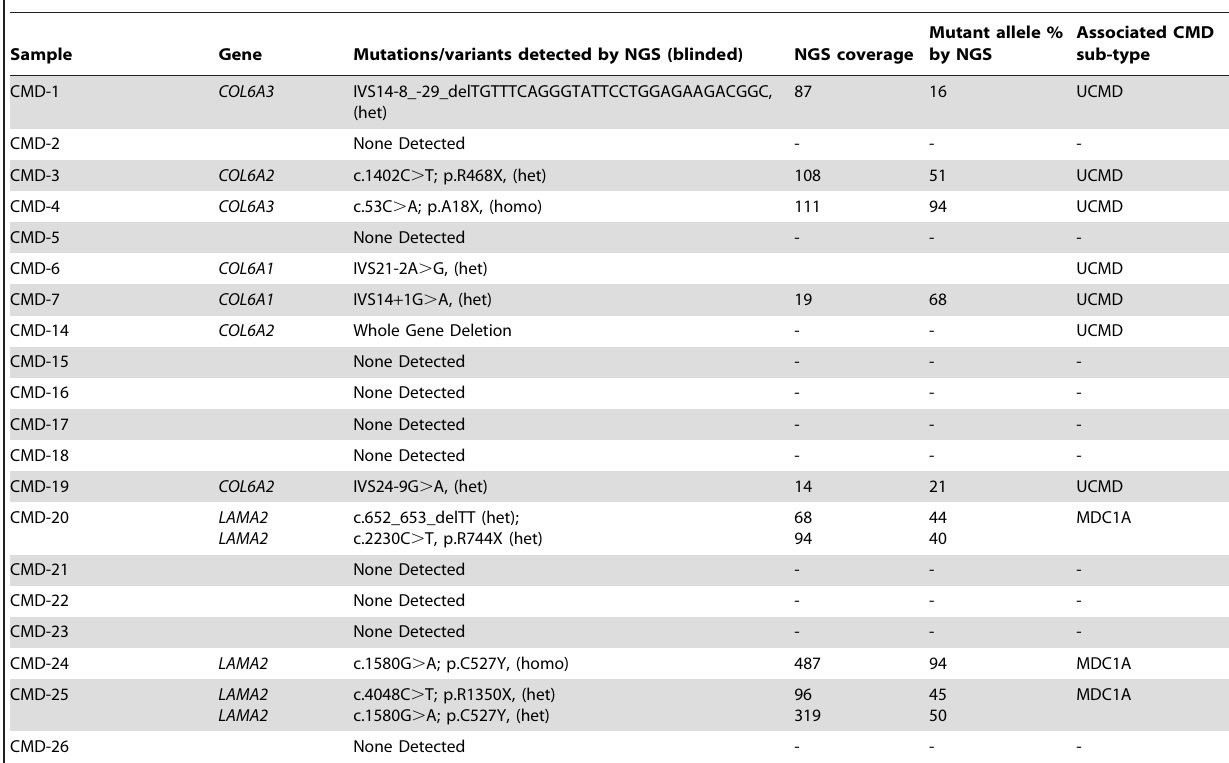
Table 7. Potential causative variants and mutations identified in the blinded clinical samples.